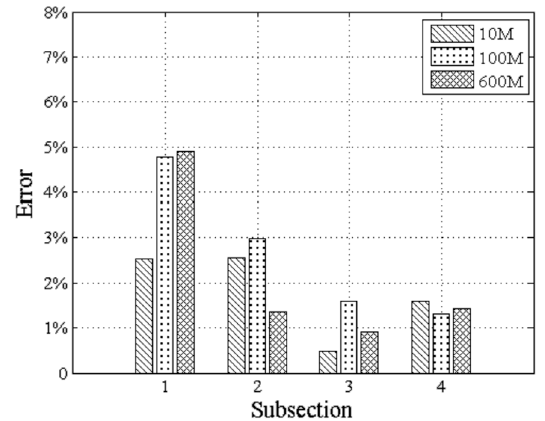
Figure 5. The piecewise representation of the maximum error, subsections 1 to 4 represent frequency offset range 10–100 Hz, 100 Hz–1 kHz, 1–10 kHz, and 10–100 kHz respectively.